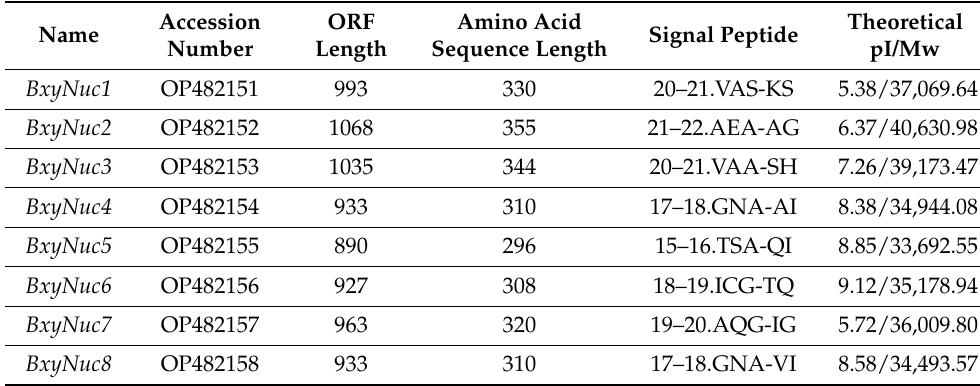
Table 1. Information table of cloned B. xylophilus extracellular